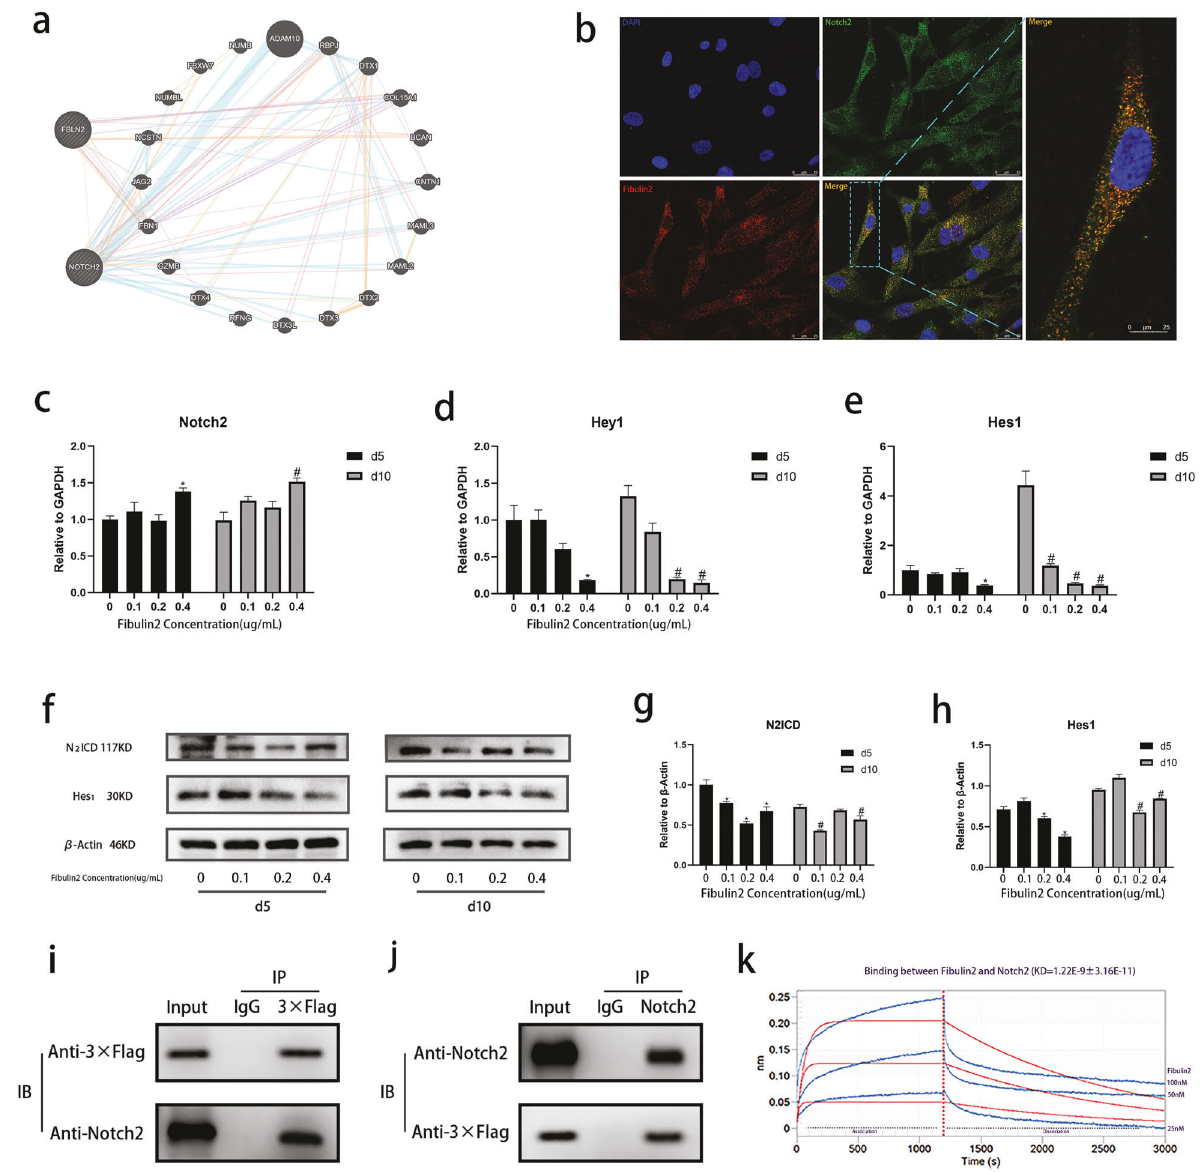
Fig. 5 Fibulin2 interacts with Notch2 and inactivates the Notch2 signaling pathway. a A bioinformatics analysis-based prediction suggested that Fibulin2 may interact with Notch2. b Double-labeling immuno fl uorescence staining revealed that Fibulin2 colocalized with Notch2 in BMSCs. The area with a dotted line is magni fi ed and shown on the right. c – e Expression of Notch2 pathway genes. (*the Fibulin2 group vs. the control group, P < 0.05 on Day 5; #the Fibulin2 group vs. the control group, P < 0.05 on Day 10; n = 3). f WB was performed to detect N2ICD and Hes1 expression levels. g, h Quanti fi cation by WB. (*the Fibulin2 group vs. the control group, P < 0.05 on Day 5; #the Fibulin2 group vs. the control group, P < 0.05 on Day 10; n = 3). i, j Coimmunoprecipitation of Fibulin2 and Notch2. BMSCs were transfected with lentivirus expressing 3×Flag-tagged Fibulin2. i Cell lysates were immunoprecipitated with anti-3×Flag antibody or control IgG. The immunoprecipitates were immunoblotted with anti-Notch2 antibody. j Cell lysates were immunoprecipitated with anti-Notch2 antibody or control IgG. The immunoprecipitates were immunoblotted with anti-3×Flag antibody. k BLI-based biosensor technology was applied to demonstrate that Fibulin2 (Ala28 – Leu1184) bound to Notch2 (Leu26 – Gln530). The blue curves represent the true association and dissociation signals. The red curves show the curve fi tting results. KD = 1.22 × 10 − 9 ± 3.16 × 10 − 11